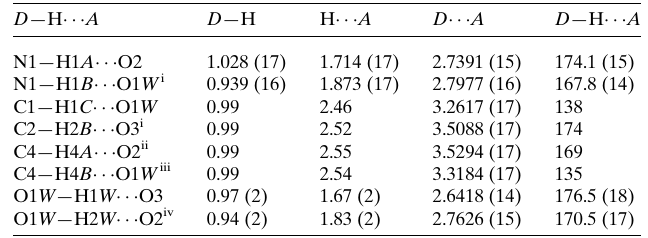
Table 3 Hydrogen-bond geometry (A˚ , (cid:5) ) for III .